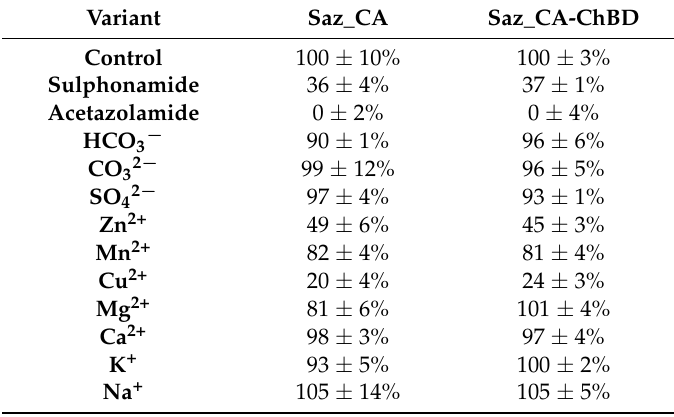
Table 3. Effect of ions and inhibitors (all 1 mM final) on enzymatic activity of Saz_CA variants.